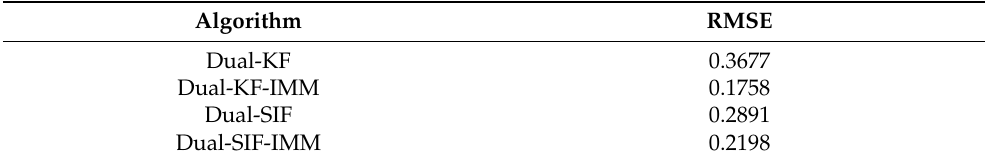
Table 5. B034 RMSE: Battery Capacity Estimation.